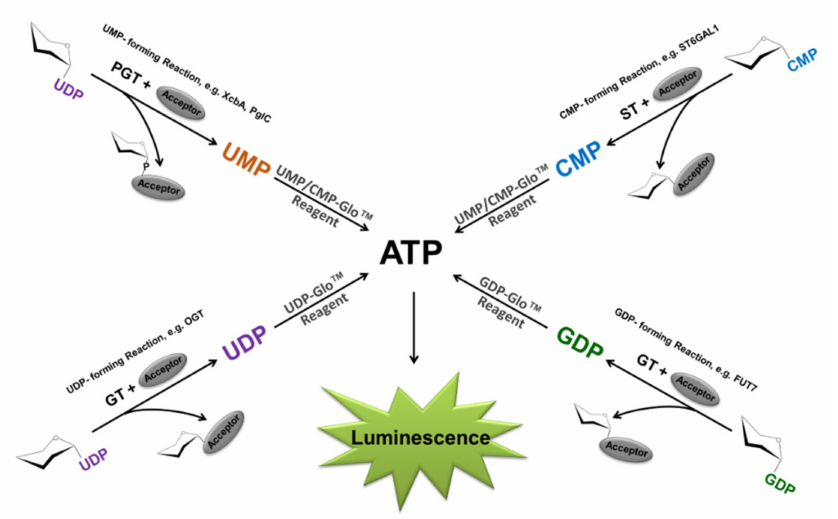
Figure 1. Bioluminescent nucleotide assays principle. UDP, GDP, UMP/CMP-Glo assays detect the corresponding nucleotides generated as a result of glycosyltransferase activity. The Glycosyl- transferase Glo assays are performed in one step after the completion of the GT reaction. The nucleotide-Glo reagents contain a converting enzyme specific for either UDP, GDP, or UMP/CMP that converts the produced nucleotide to ATP. Simultaneously, the newly formed ATP is used by the luciferin/luciferase system to generate luminescence. The light generated correlates to the nucleotide present and glycosyltransferase